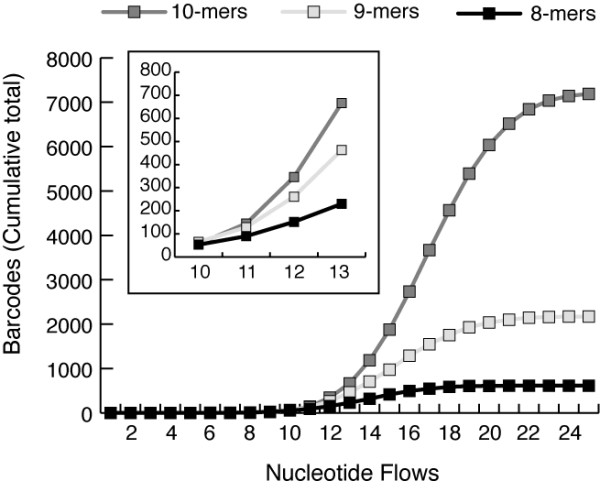
Cumulative distribution of barcodes as function of pyrosequencing nucleotide flows. Barcrawl analyses were performed for range of barcode lengths. The cumulative sums of selected barcodes are plotted vs. pyrosequencing nucleotide flows. The inset box shows the region of this plot bounded by flows 10-13 and illustrates that about flow #11, the sequence space of 10-mers > 9-mers > 8-mers.